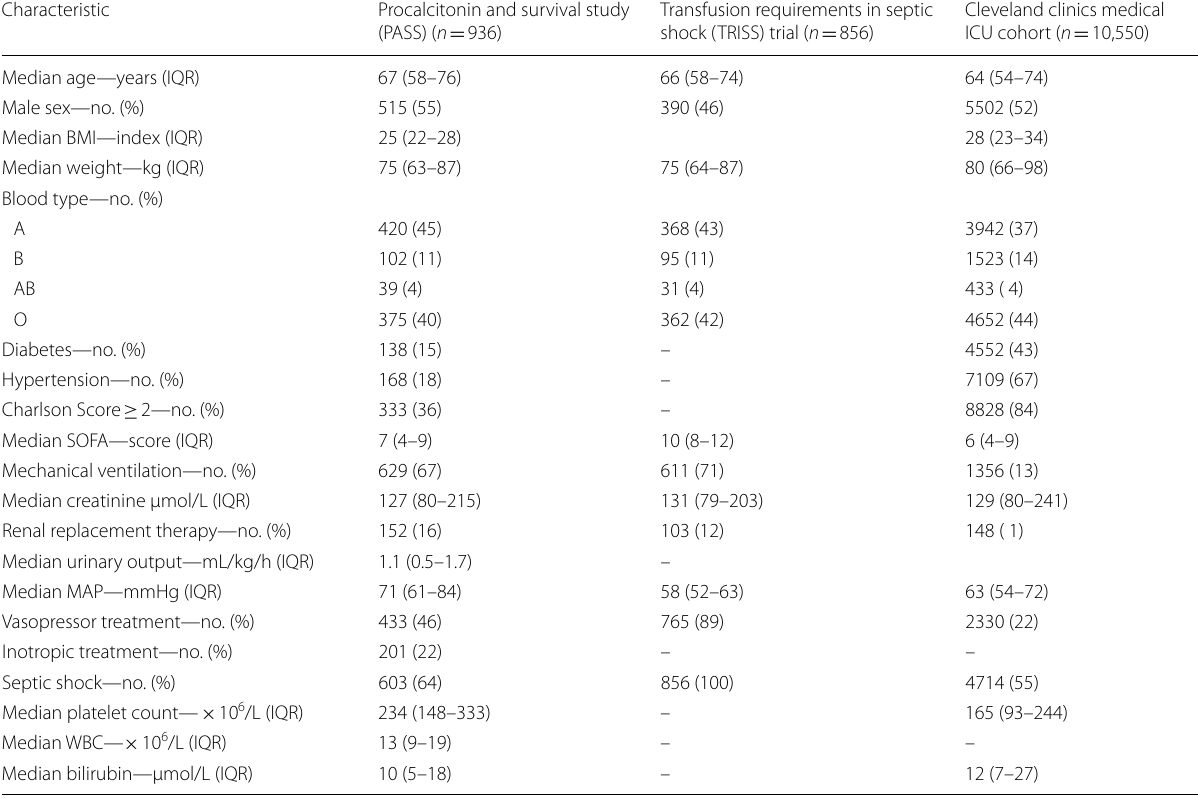
Table 1 Baseline characteristics in the study cohorts Characteristic Procalcitonin and survival study